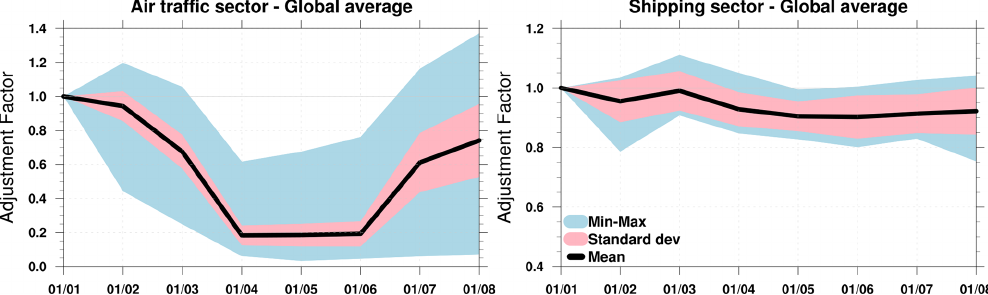
Figure 3. AF time series for air traffic and shipping as a function of month from January to August 2020. The standard deviation values (light pink) are calculated based on the AFs of all individual countries, while the light-blue color indicates the range of the minimum and maximum values.